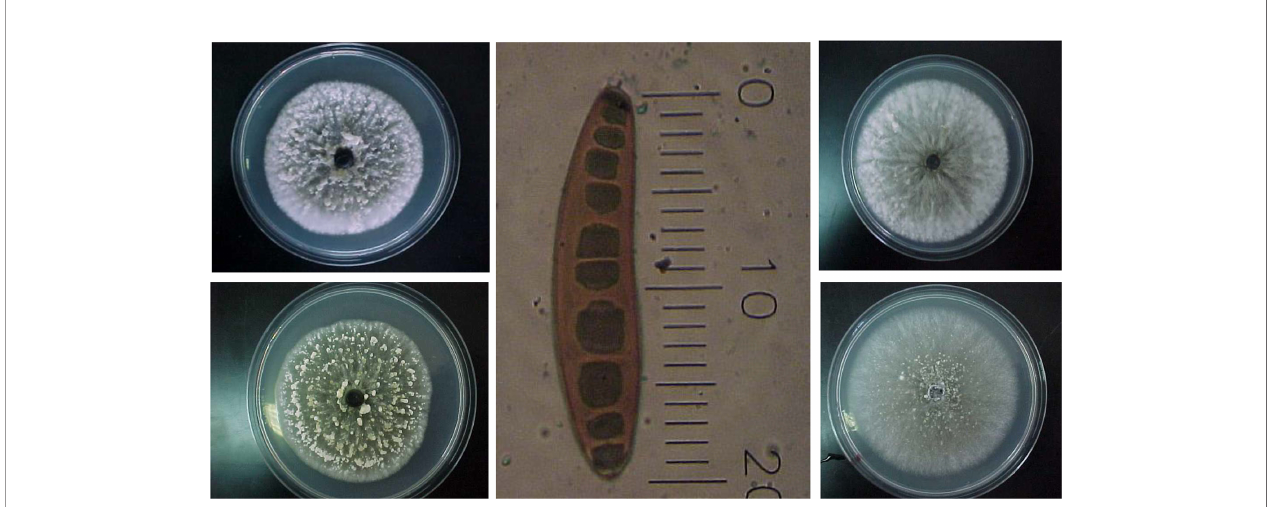
FIGURE 1 | Morphology of Bipolaris sorokiniana culture and spores (1 scale is equivalent to 5 µm) grown on potato dextrose agar. The mycelial growth of the four isolates shows mixed color (white and black) as explanied by Navathe et al. (2020), with varying intensities of the black color among the